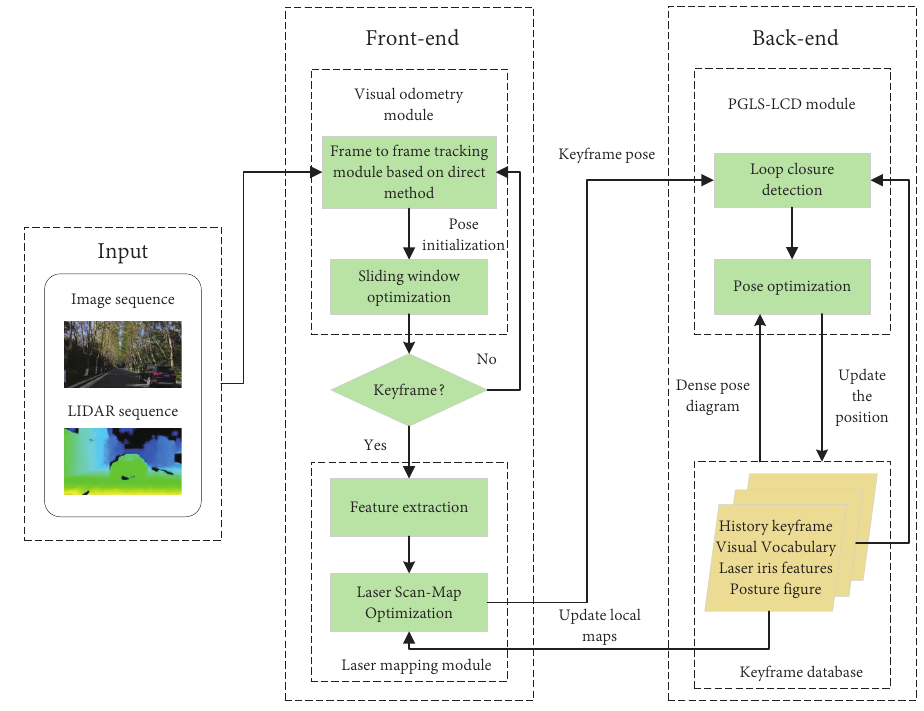
Figure 18. Framework diagram of VL-SLAM based on the direct